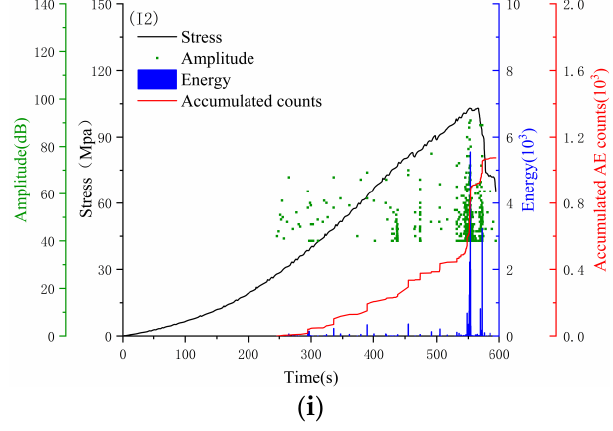
Figure 8. The evolution of stress, AE energy, accumulated AE counts, and amplitude with time under different moisture content. ( a – i ) Specimens under different moisture content.